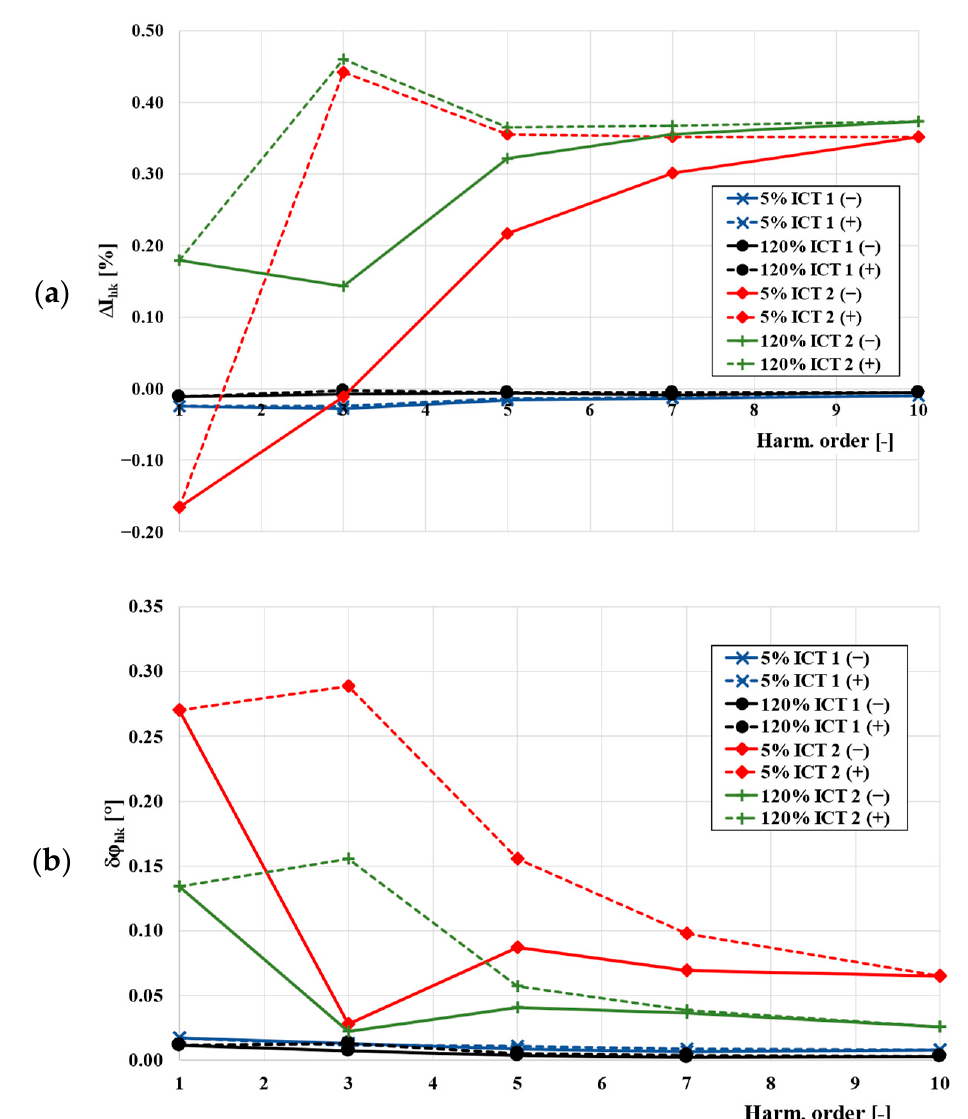
Figure 5. Comparison of determined values of the current error ( a ) and phase displacement ( b ) for both tested CTs up to 10th higher harmonic and 25% of the rated load of the secondary winding. Also, for the decreased load of the secondary winding, the high metrological perfor- mance of the ICT 1 is retained. The positive values of current error determined for ICT 2 results from applied turns number correction, where the real turns ratio is not equal to the rated current ratio [30]. The ICT 1 is not corrected. It should be noticed that ICT 2 is characterized by relevantly low values of current error and phase displacement. Therefore, decreasing the secondary winding load typically ensures better metrological performance for transforming higher harmonics of the distorted primary current [31]. Figure 6 presents the determined values of current error and phase displacement for both tested CTs up to 100th higher harmonic and 25% of the rated load of the secondary